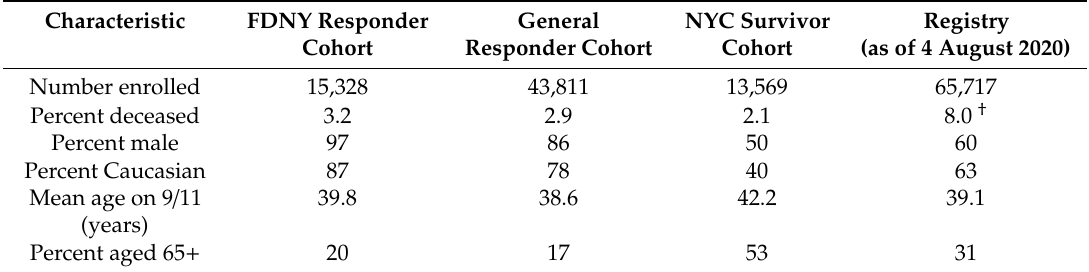
Table 1. World Trade Center Health Program (WTCHP) and Registry Members